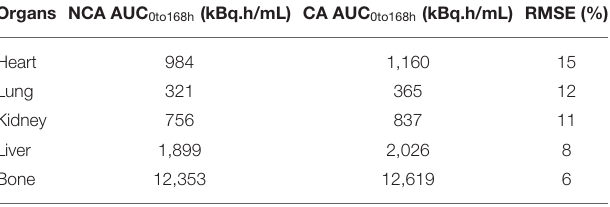
TABLE 2 | Comparison between NCA and CA mean AUC estimations.